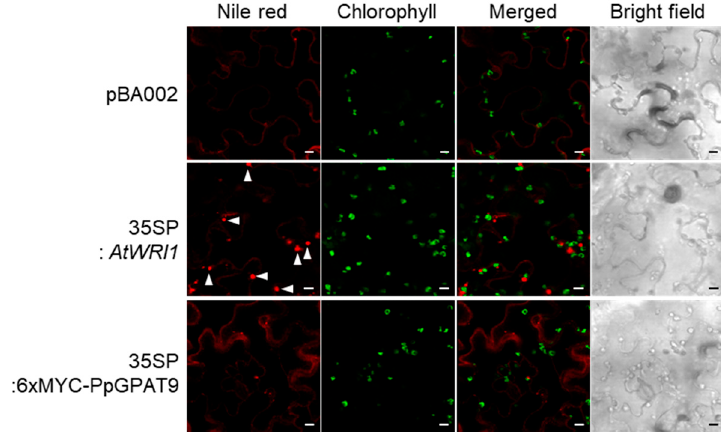
Figure 7. Transient expression of PpGPAT9 in N. benthamiana leaves. Agrobacterium harboring pBA002 (for the control); AtWRI1 or PpGPAT9 was infiltrated into N. benthamiana leaves, and the leaf disks were stained with Nile red solution. The fluorescent signals were visualized using confocal laser scanning microscopy. The arrowheads indicate oil bodies. Bars = 20 µ